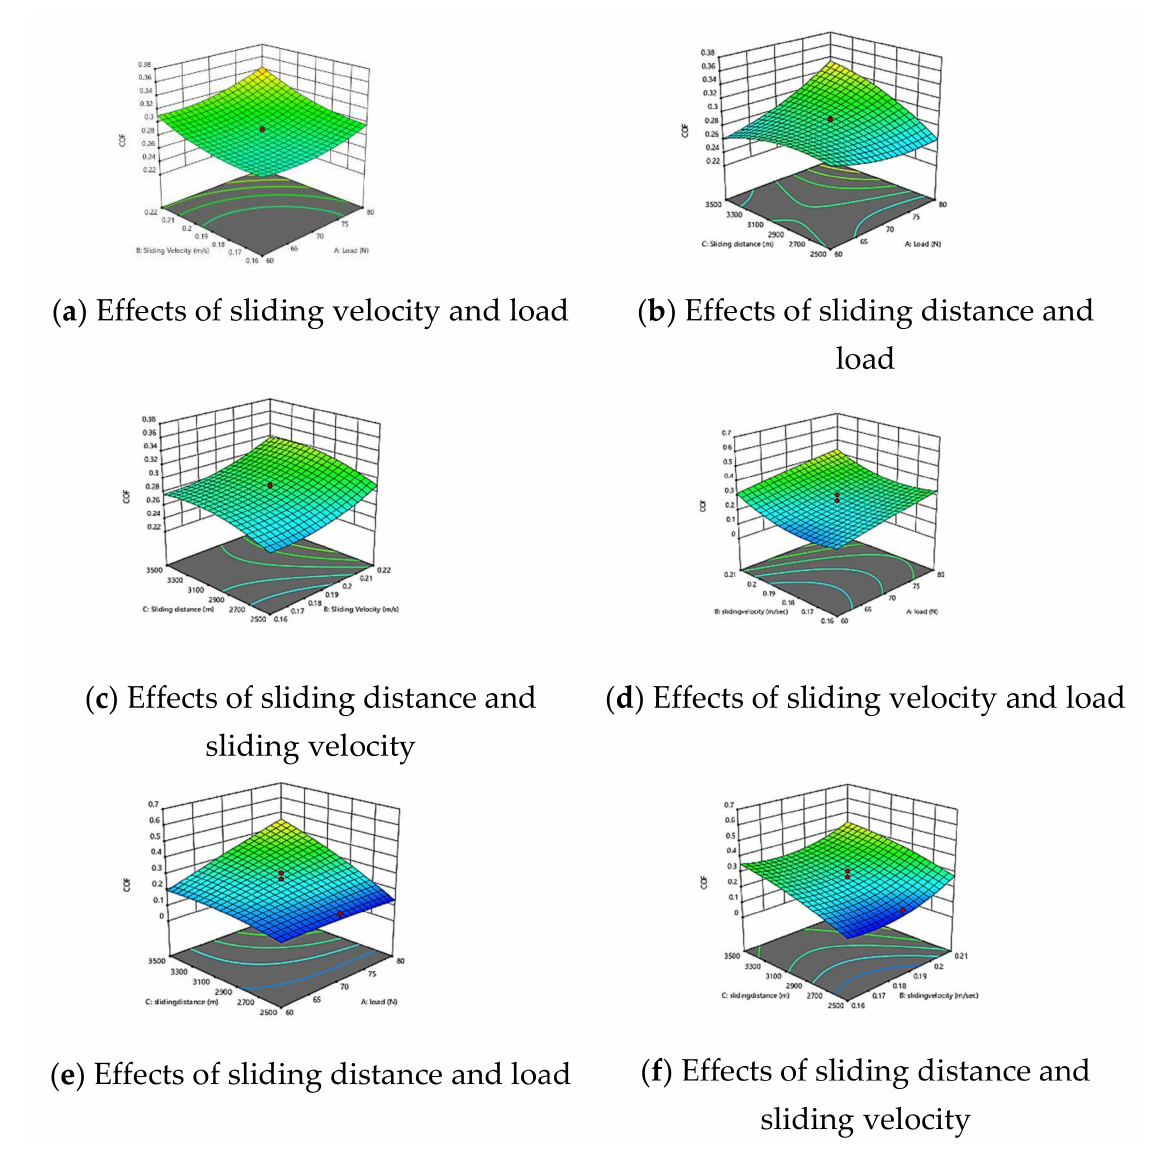
Figure 6. 3D surface of COF model GFRPA66 30 wt.% and GFRPA66 35 wt.%; ( a ) GFRPA66 30 wt.% effects of sliding velocity and load, ( b ) GFRPA66 30 wt.% effects of sliding distance and load, ( c ) GFRPA66 30 wt.% effects of sliding distance and sliding velocity, ( d ) GFRPA66 35 wt.% effects of sliding velocity and load, ( e ) GFRPA66 35 wt.% effects of sliding distance and load, and ( f ) GFRPA66 35 wt.% effects of sliding distance and sliding